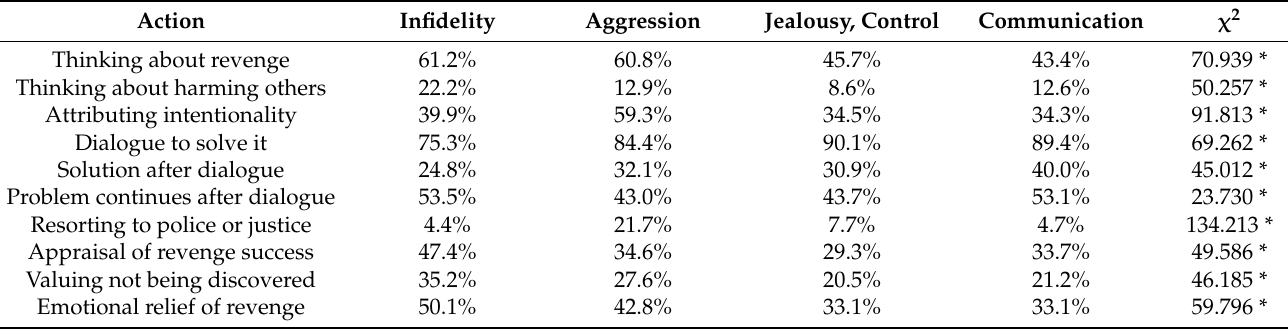
Table 1. Response percentages for each reaction to perceived transgressions committed by the romantic partner. Action Infidelity Aggression Jealousy, Control Communication χ